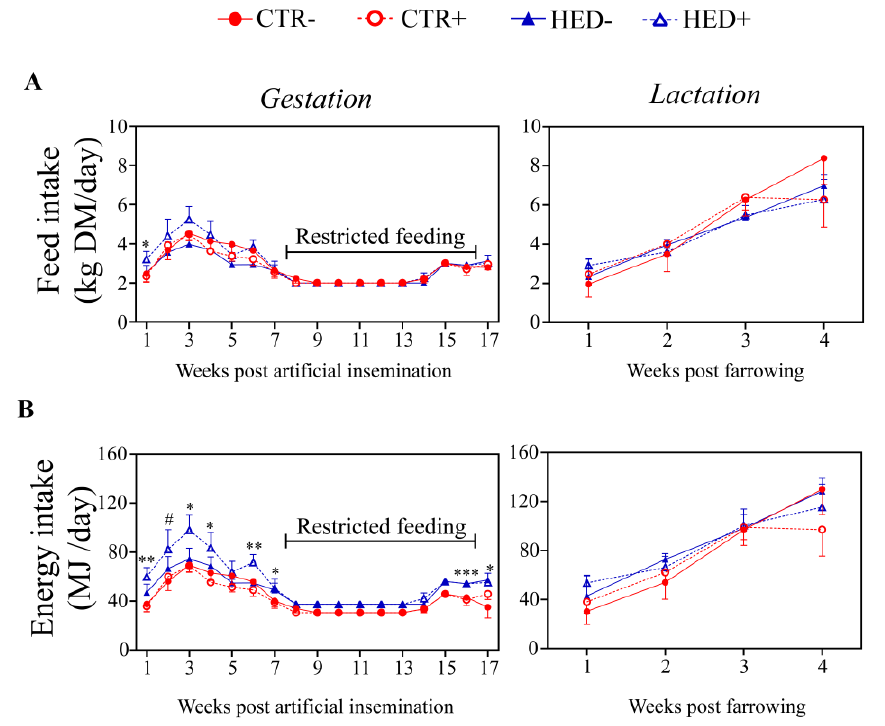
Figure 2. Effect of high-energy diet and spirulina supplementation on feed and energy intake of primiparous sows during gestation and lactation. ( A ) Feed intake during gestation and lactation (CTR- n = 5, CTR+ n = 6, HED- n = 5, and HED+ n = 4); ( B ) gross energy intake during gestation and lactation (CTR- n = 4, CTR+ n = 6, HED- n = 5, and HED+ n = 4). CTR: control diet; HED: high-energy diet. Data are presented in line graphs, where each point represents mean ± standard error of the mean (SEM). Significant differences were observed for dietary treatment (HED vs. CTR) and represented as * p < 0.05, ** p < 0.01, *** p < 0.001, and # p < 0.1 (trend). During the restricted feeding period, no statistical significance in energy intake was detected due to the absence of variance within groups.